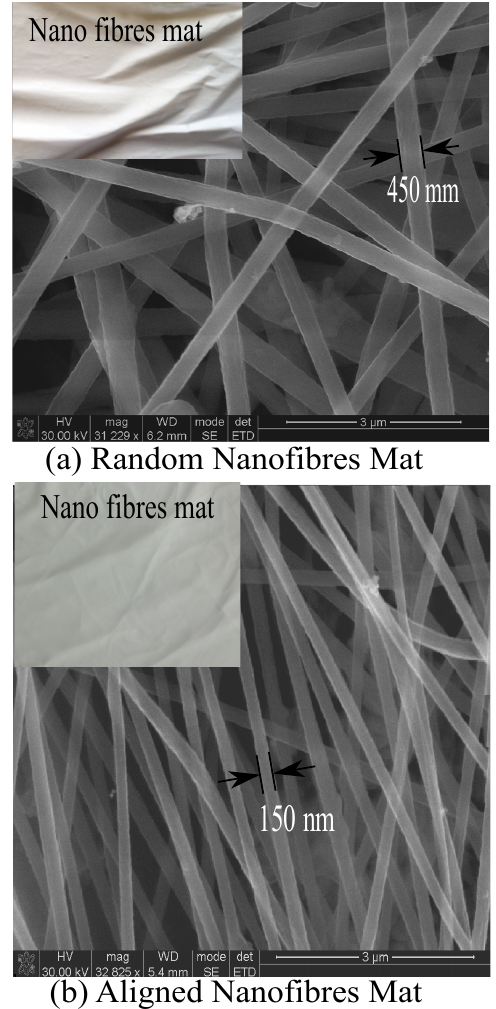
Figure 4. Electrospun nanofibers mats ( a ) without AVEs; ( b ) with